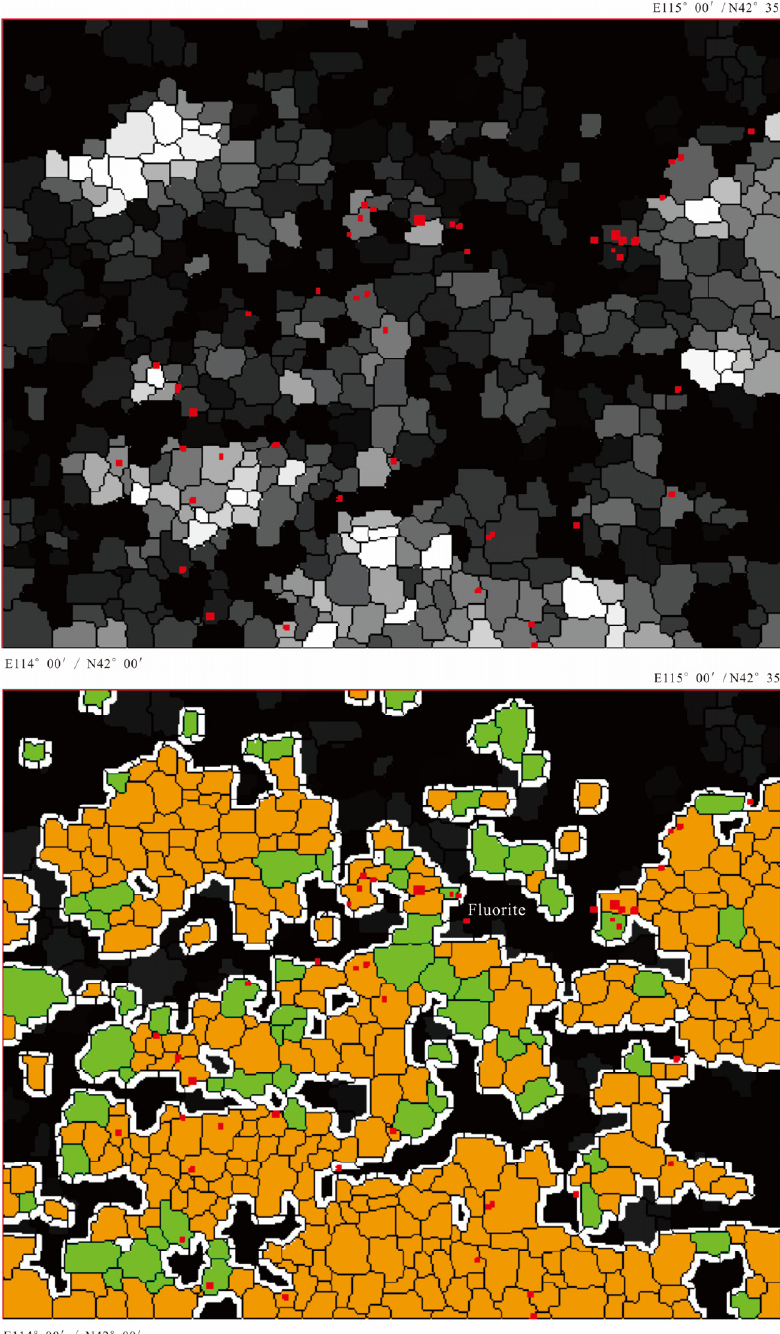
Figure 10. ( upper ) the object-based anomaly-score base map with known S-series ore spots (red squares) overlaid on it; ( lower ) the delineated anomalous regions (green-colored patches—Level II anomalies, orange-colored patches—Level I anomalies, delineated by the 60% quantile) with mineral spots overlaid on it. We also created a 4-pixel buffering zone (white colored belts) around the known anomalous regions. Note: the mineral species include Fe, Mo, Ag-Pb-Zn-Fe, Ag-Pb-Zn, Pb-Zn, Ag-Pb, Pb, W, Nb-Ta, Rb-Nb-Ta, Fluorite, W-Mo, Beryl, U, and etc. Other legends in this figure are consistent with those in Figure 9 if not